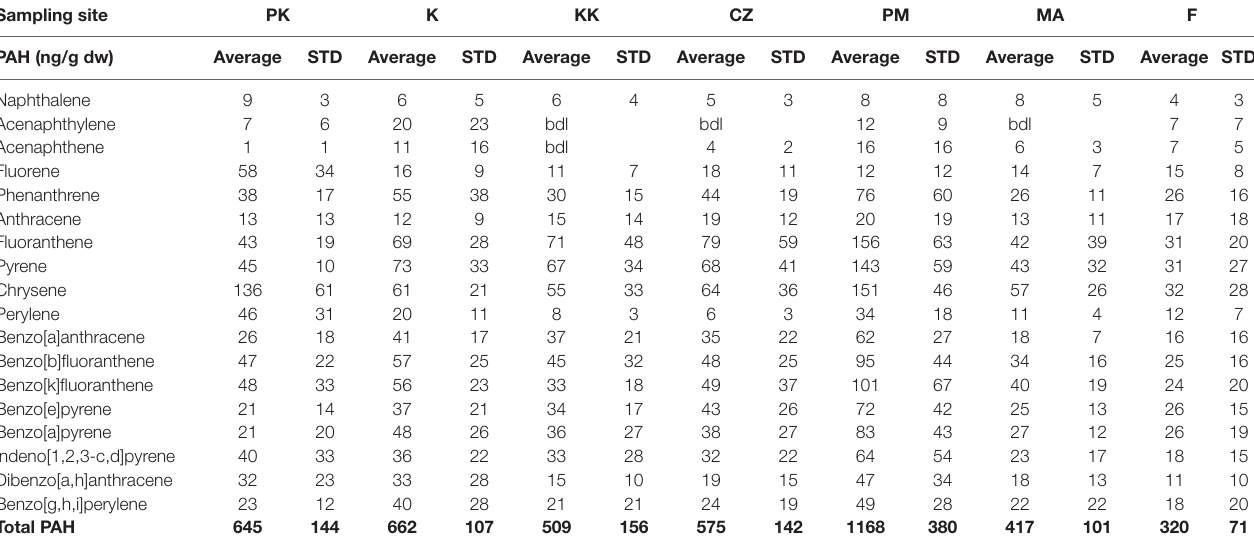
TABLE 2 | Average concentrations of PAH in sediment samples in the study